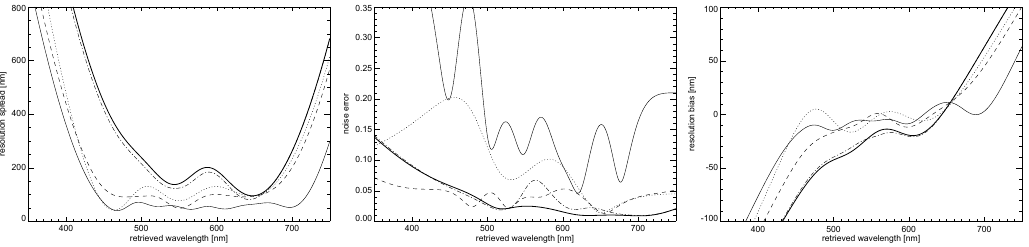
Figure 20. Retrieval resolution ( q 2 ) noise and bias ( q 3 ) for MX7C fast (thick solid line), MX7C raw (dotted), H9C/MX7C (dashed), 2 × MX7C with multinotch filter (dash-dot), and 3 × MX7C with two sinusoidal filters (thin